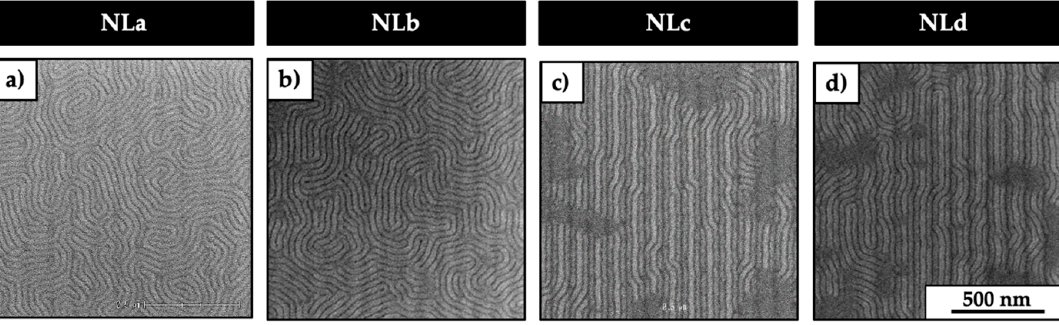
Figure 4. Representative top-view CD-SEM images of the self-assembled films when using NLa ( a ), NLb ( b ), NLc ( c ), and NLd ( d ) as neutral